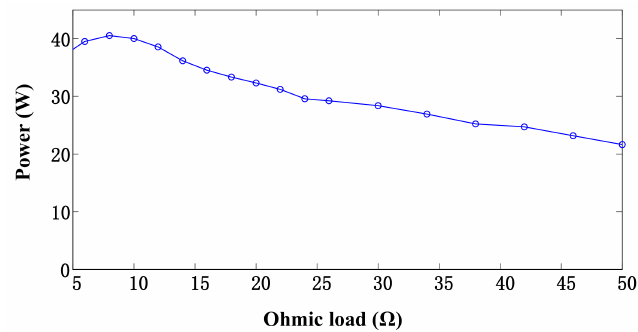
Figure 12. Output power with different ohmic loads.